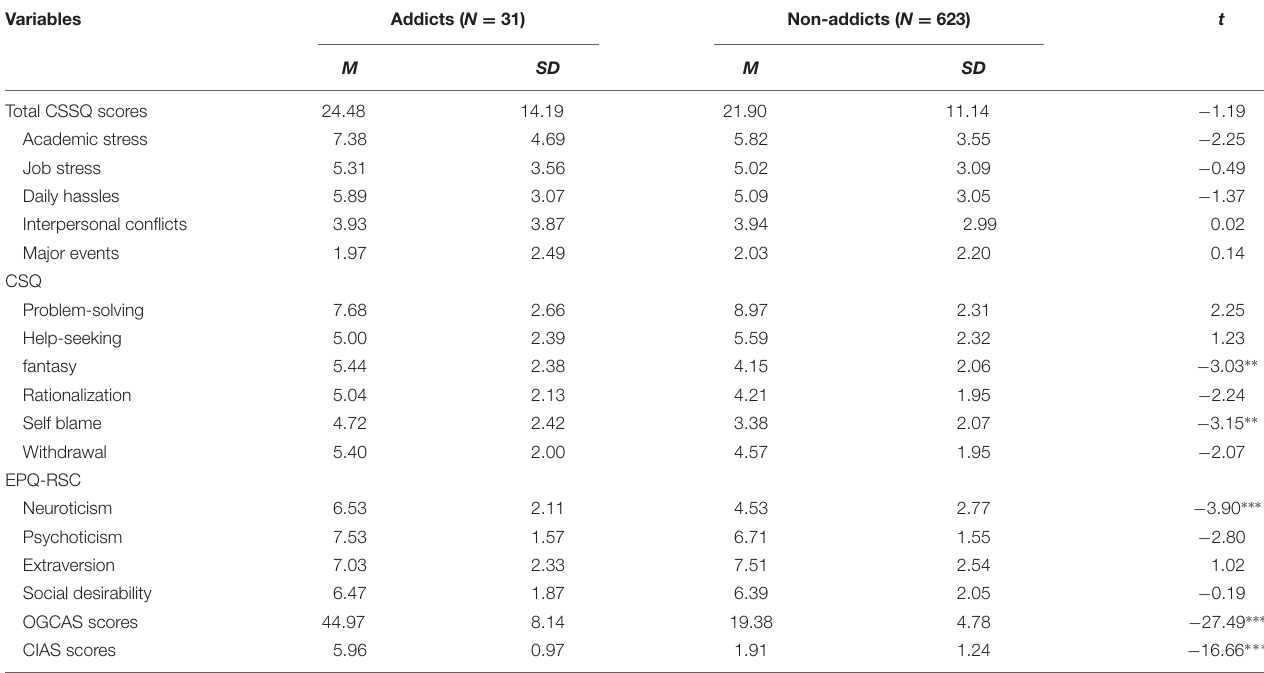
TABLE 2 | Means and standard of stressful life events, coping strategies, personality traits, and online game addiction (OGA). Variables Addicts ( N = 31)